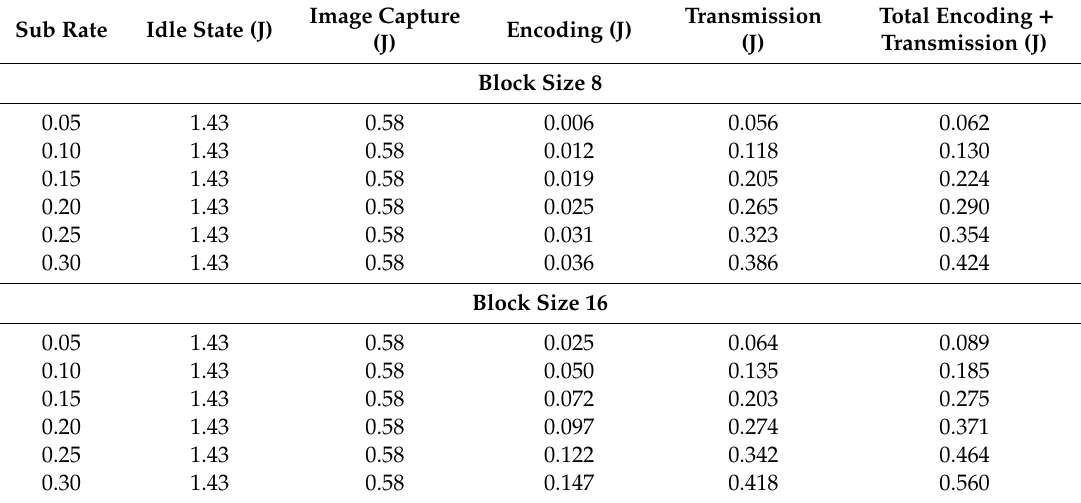
Table 3. Energy consumption using block size 8 × 8 and 16 × 16 at various